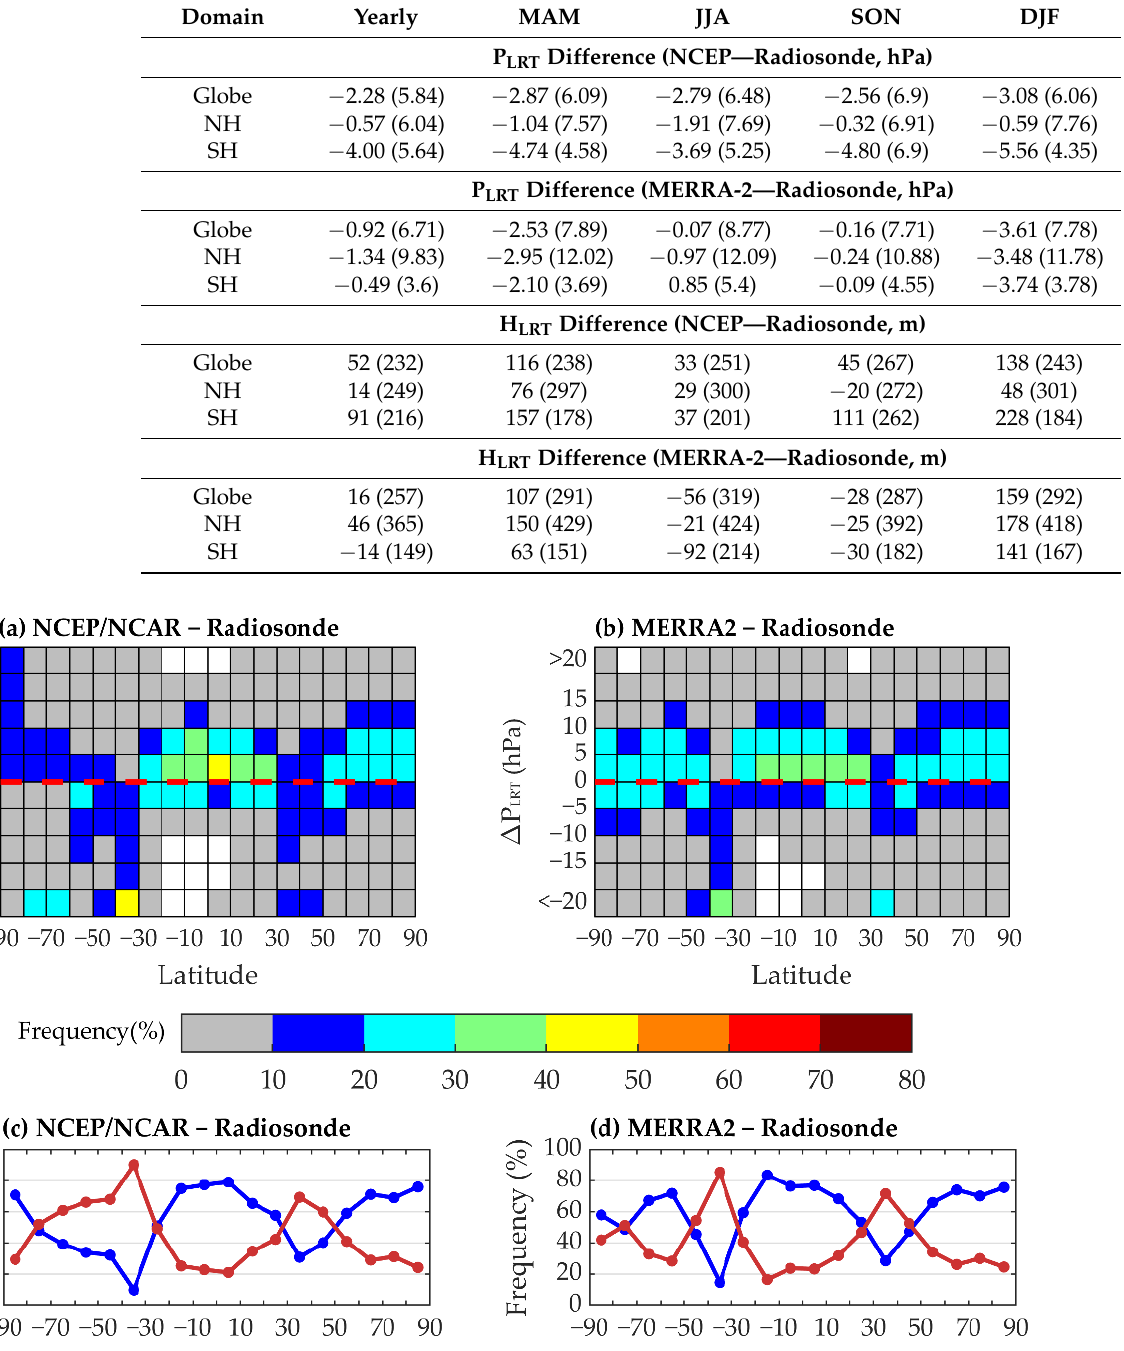
Table 1. Means and standard deviations (in brackets) of P LRT biases (in hPa, top panel) and H LRT